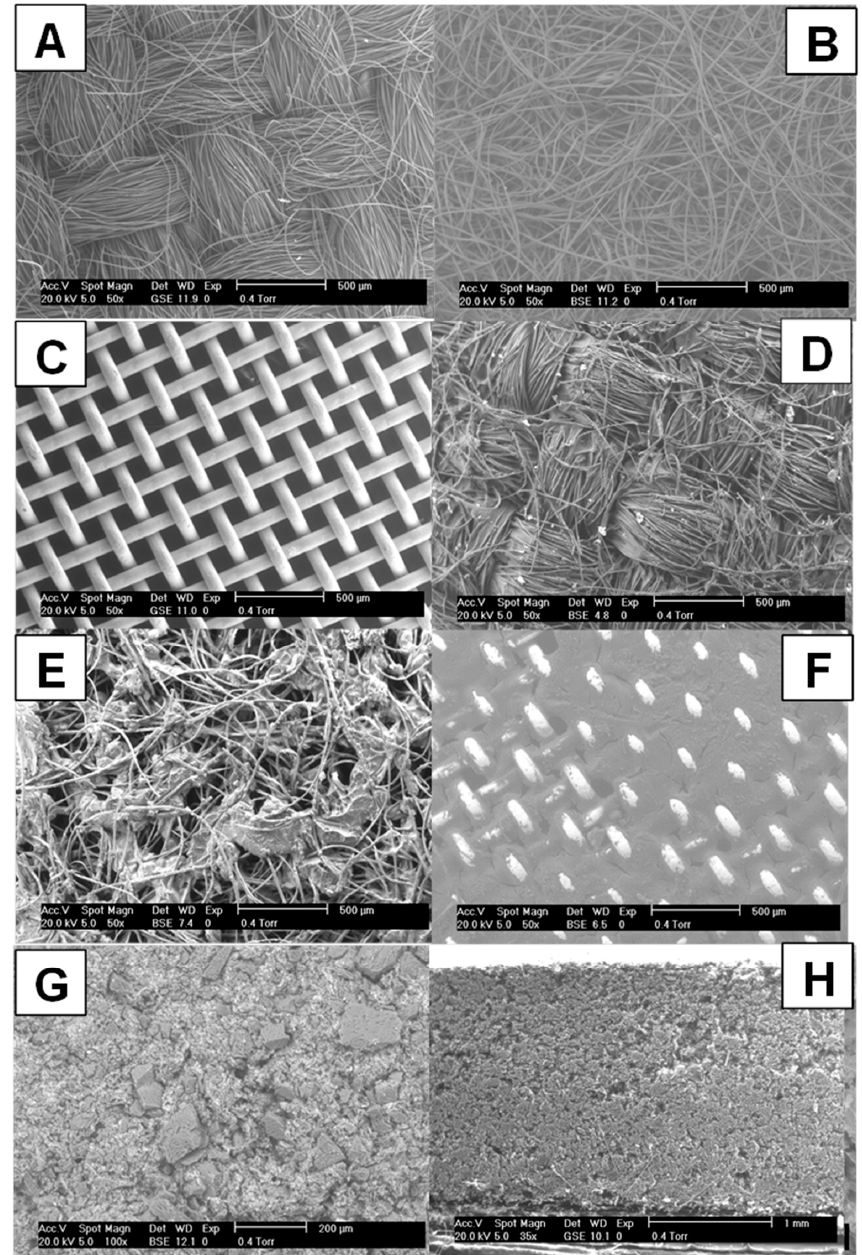
Figure 3. Environmental scanning electron microscope (ESEM) images of the different substratum materials: ( A ) CC (carbon cloth); ( B ) CF (carbon felt); ( C ) (SS stainless steel) mesh; supporting materials with the MPL (micro-porous layer): ( D ) CC + MPL; ( E ) CF + MPL; ( F ) SS + MPL; AC layer, no substratum: ( G ) front view and ( H ) side view.